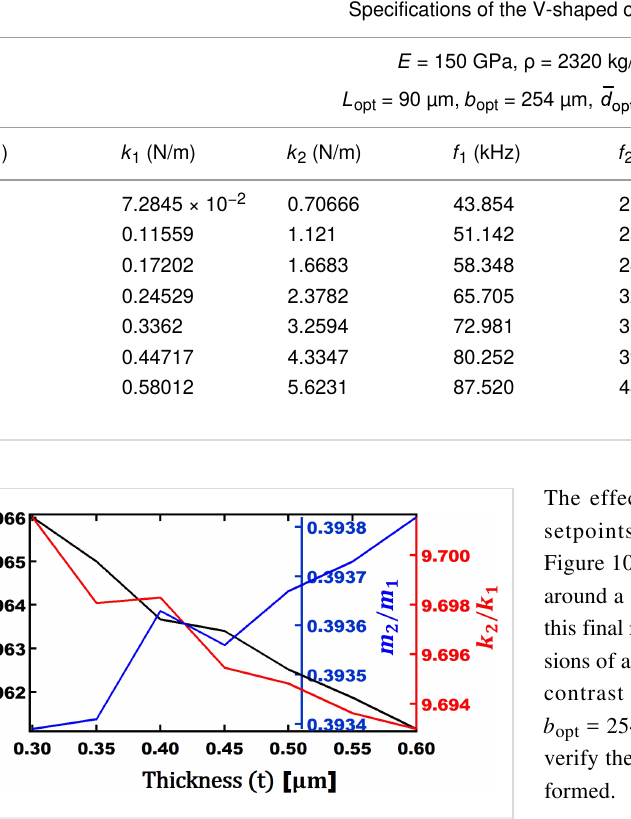
Figure 9: Ratio of second eigenmode to first eigenmode versus thick- ness ( t ) of V-shaped cantilevers for: frequency (black axis), mass (blue axis), and stiffness (red axis). The other geometrical parameters : L opt = 90 µm, b opt = 254 µm, and = 32